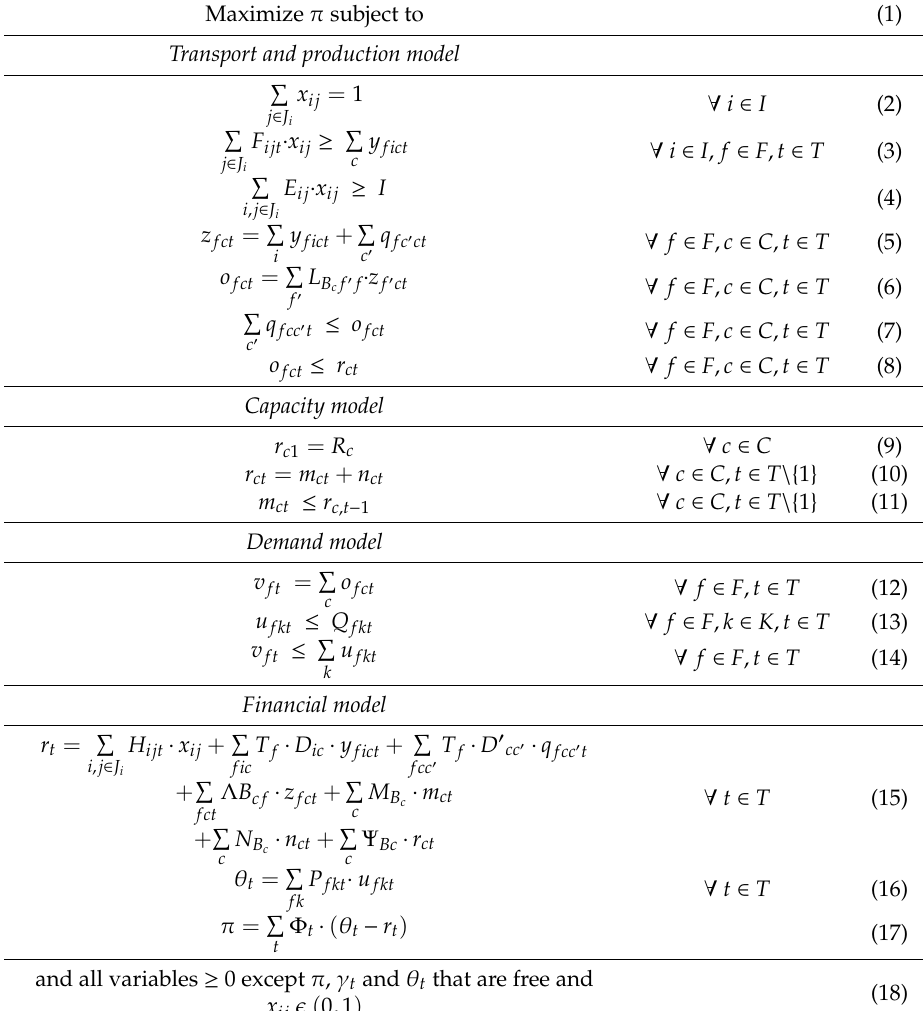
Table 2. Mathematical description of the SweFor